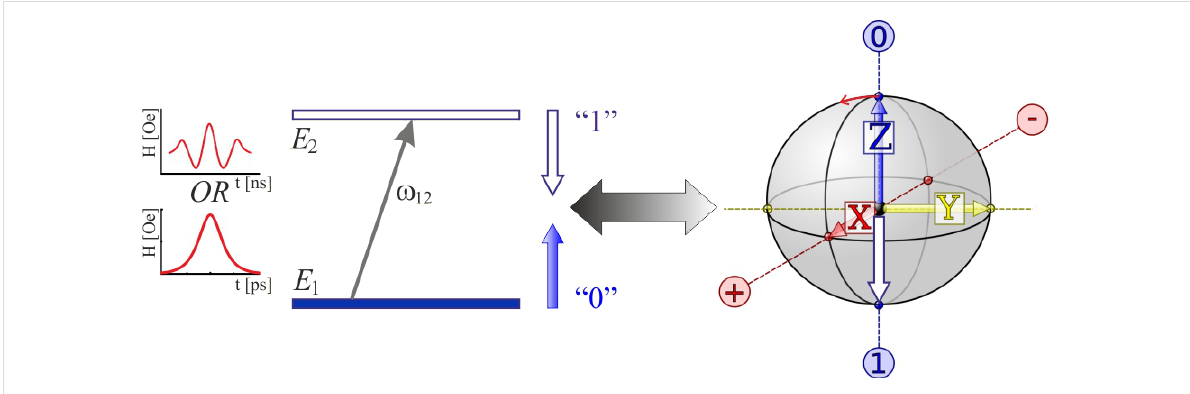
Figure 1: Magnetization reversal of a two-level system is shown as a transition between the states “0” and “1” for certain values of the magnetic moment (these states correspond to the energy levels of E 1 and E 2 , respectively) by either a unipolar or oscillating magnetic field. The given tran- sition is somewhat analogous to the rotation of the Bloch vector or to the precession of the magnetic moment under the influence of a magnetic field perpendicular to the plane of